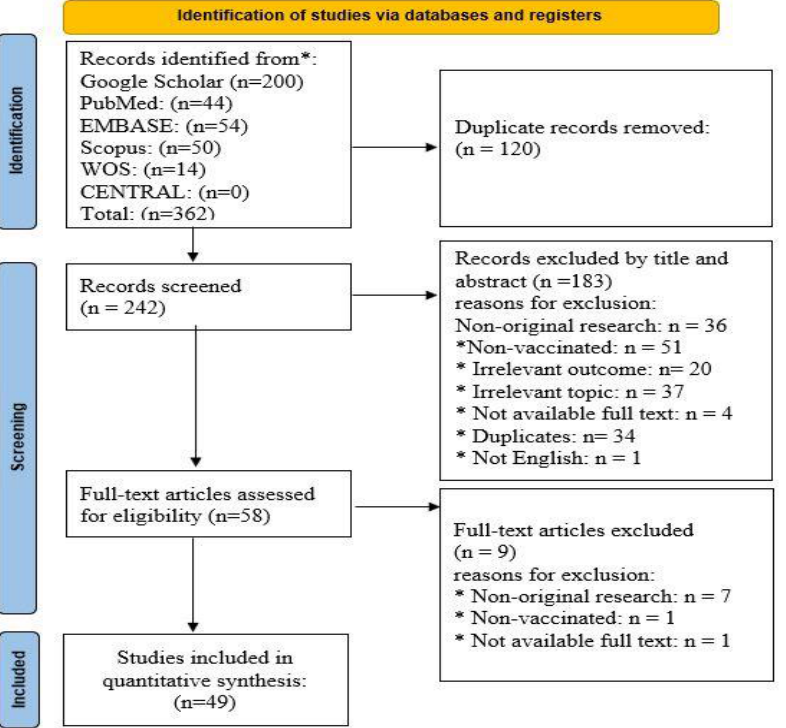
Table 1. Summary of papers reviewed in this systematic review. No.